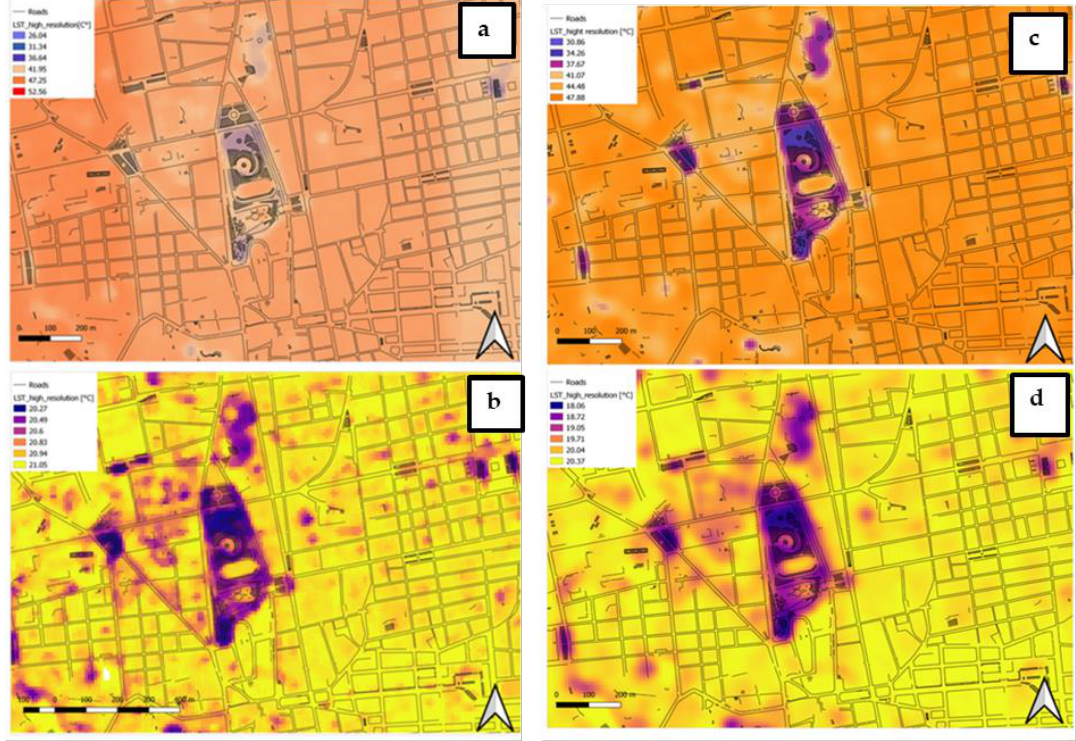
Figure 7. Daytime ( a ) and nighttime ( b ) LST 10 on 14 July 2017. Daytime ( c ) and nighttime ( d ) LST 10 on 26 August 2017.